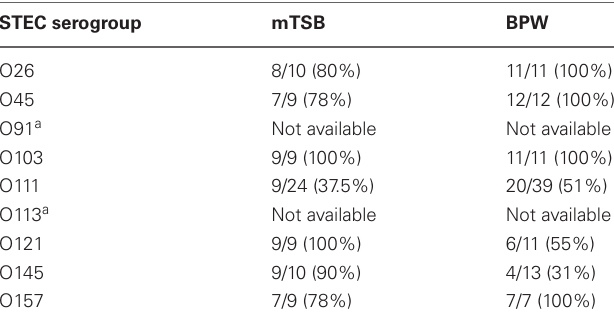
Table 4 | Number (percentage) of colonies confirmed by real-time PCR assays out of total presumptive colonies picked from Rainbow Agar